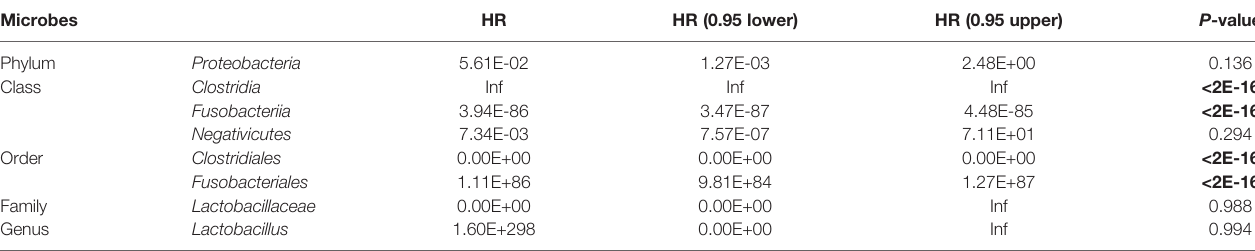
TABLE 2 | Multivariate Cox regression analysis of the independent signi fi cance of eight microbes as prognostic factors.